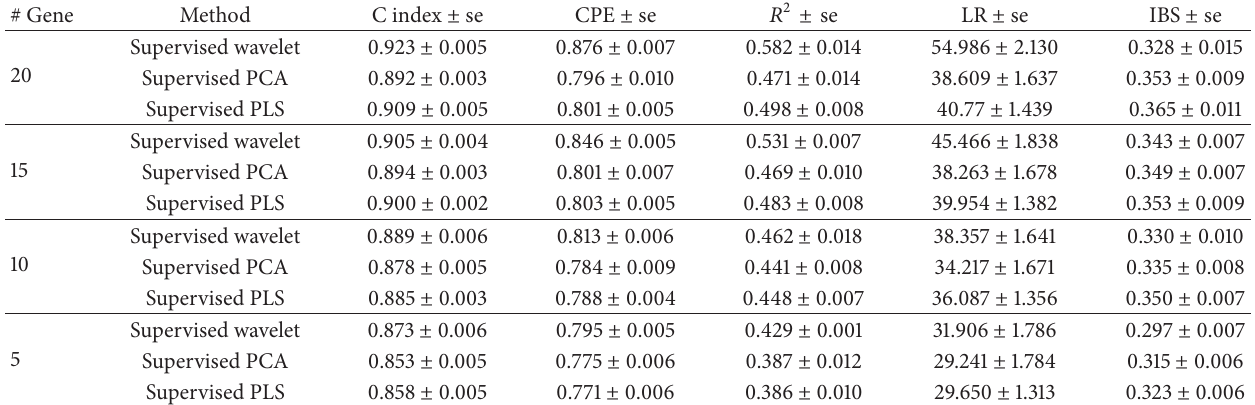
Table 3: Performance of different Cox models for lung cancer